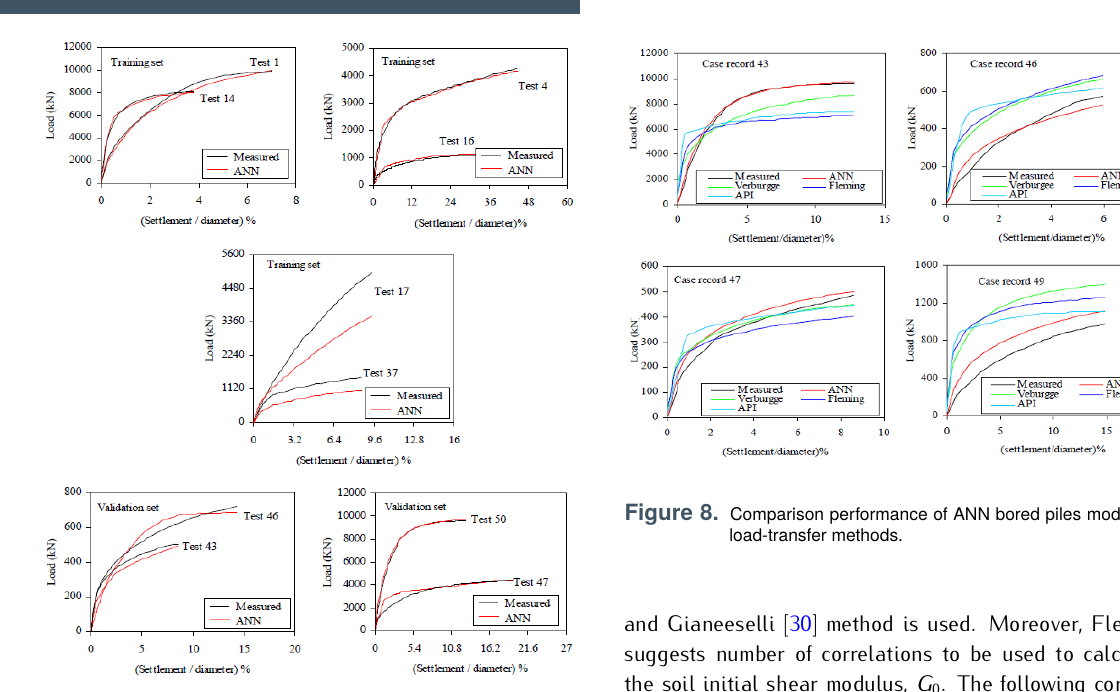
Figure 5. Some simulation results of the developed ANN Model for bored piles in training and validation sets.